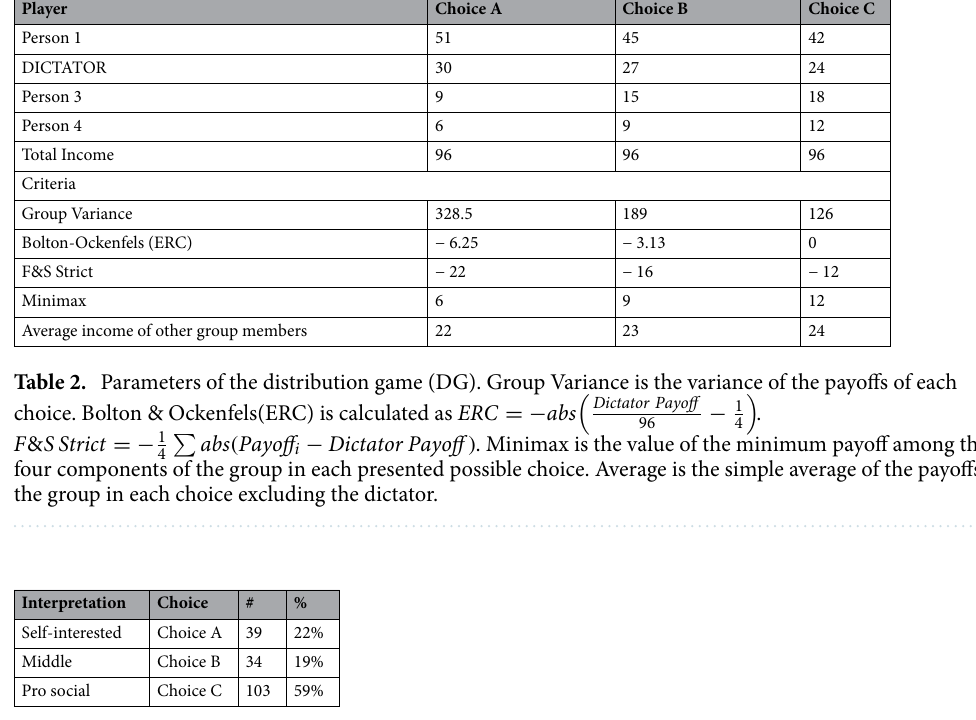
Table 3. Distribution game, number and proportion of people making each